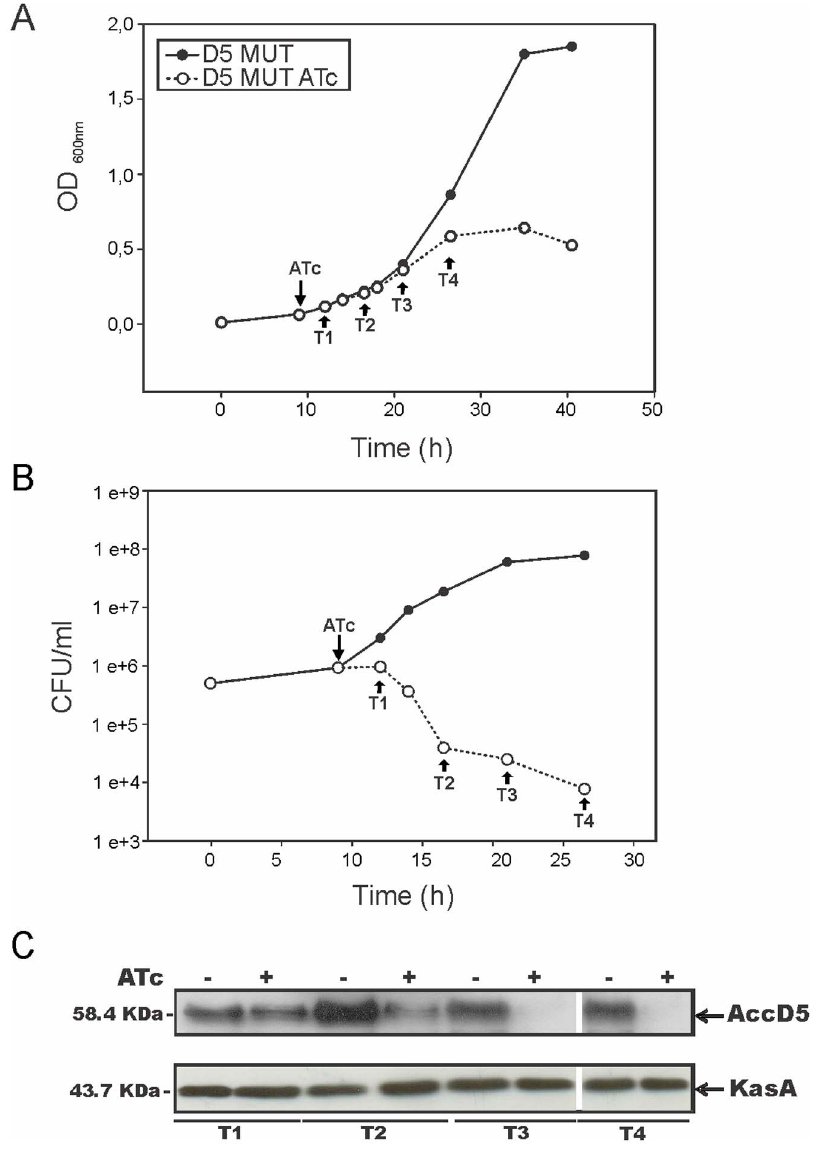
Figure 4. Effect of accD5-E5 expression on D5 MUT growth and cell viability. A saturated culture of D5 MUT grown at 37 u C was diluted in fresh 7H9 medium to an OD 600 nm of 0.01 and 9–10 h later (OD 600 nm , 0,06) ATc 200 ng ml 2 1 was added to an aliquot of the culture. A) Growth was followed by measuring OD 600 nm . Arrows indicate the times when aliquots of the cultures were collected for further analysis (T1, T2, T3 and T4). B) The number of viable cells of D5 MUT in the cultures grown in presence or absence of ATc was evaluated by plating serial dilutions onto LB plates at 37 u C. C) Western blot analysis of total crude lysates from D5 MUT strain grown with ( + ) and without ( 2 ) ATc 200 ng ml 2 1 . Detection was performed using anti-AccD5 antibodies elicited in rabbit (upper panel) and anti-KasA as loading control (lower